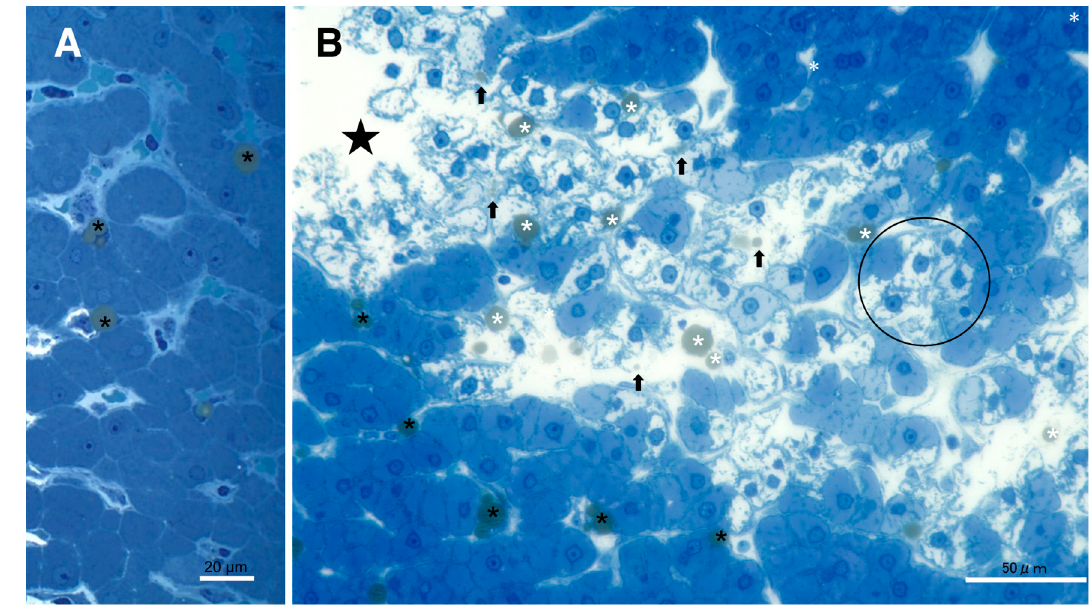
Figure 3. Accumulation of lipid droplets after the hydroxynonenal injections. In the control liver ( A ), lipid droplets were mainly seen within Ito cells next to the sinusoid lumen (( A ), black asterisks). In contrast, after hydroxynonenal injections, many lipid droplets were seen within and outside the degenerating/necrotic hepatocytes (( B ); white asterisks and arrows). The double fixation for the electron microscopic preparation preserved lipid components against acetone dehydration. The translucent cytoplasm of degenerating hepatocytes (( B ), circle) exhibited dissolution of cyto- plasmic organelles, as confirmed by electron microscopy (Figure 10B, circle). Star: focal necrotic area, T-B staining.